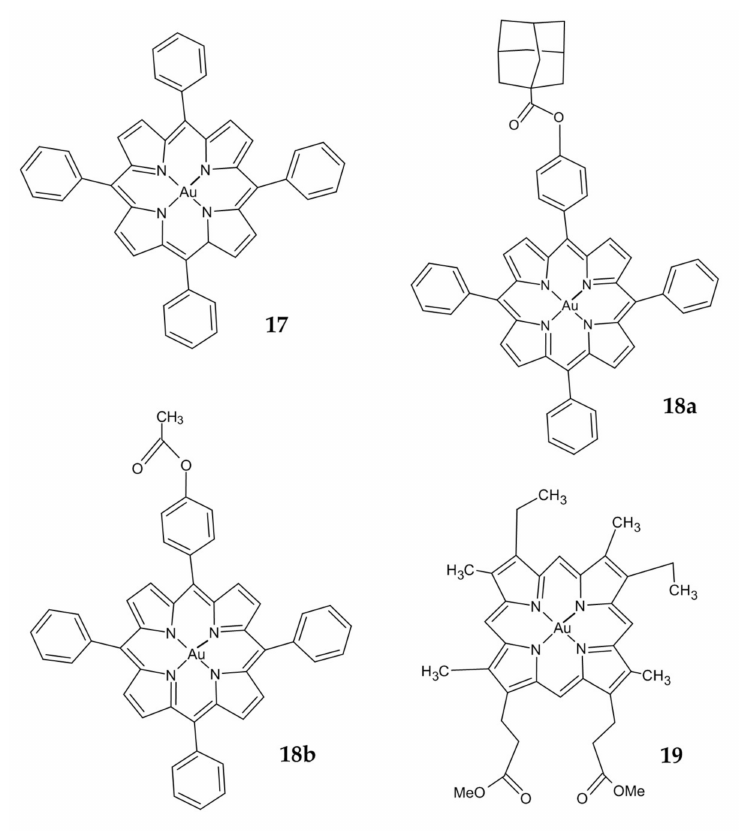
Figure 8. Au(III) porphyrin complexes 17 , 18a,b , 19 . Table 3. Characterization of the anticancer properties of porphyrin